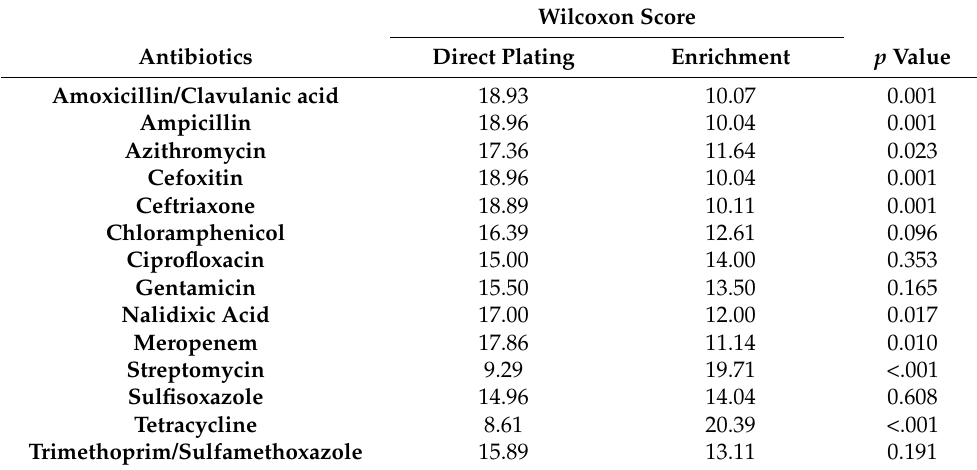
Table 5. Effects of culturing method on poultry Salmonella antimicrobial resistance in trial one.